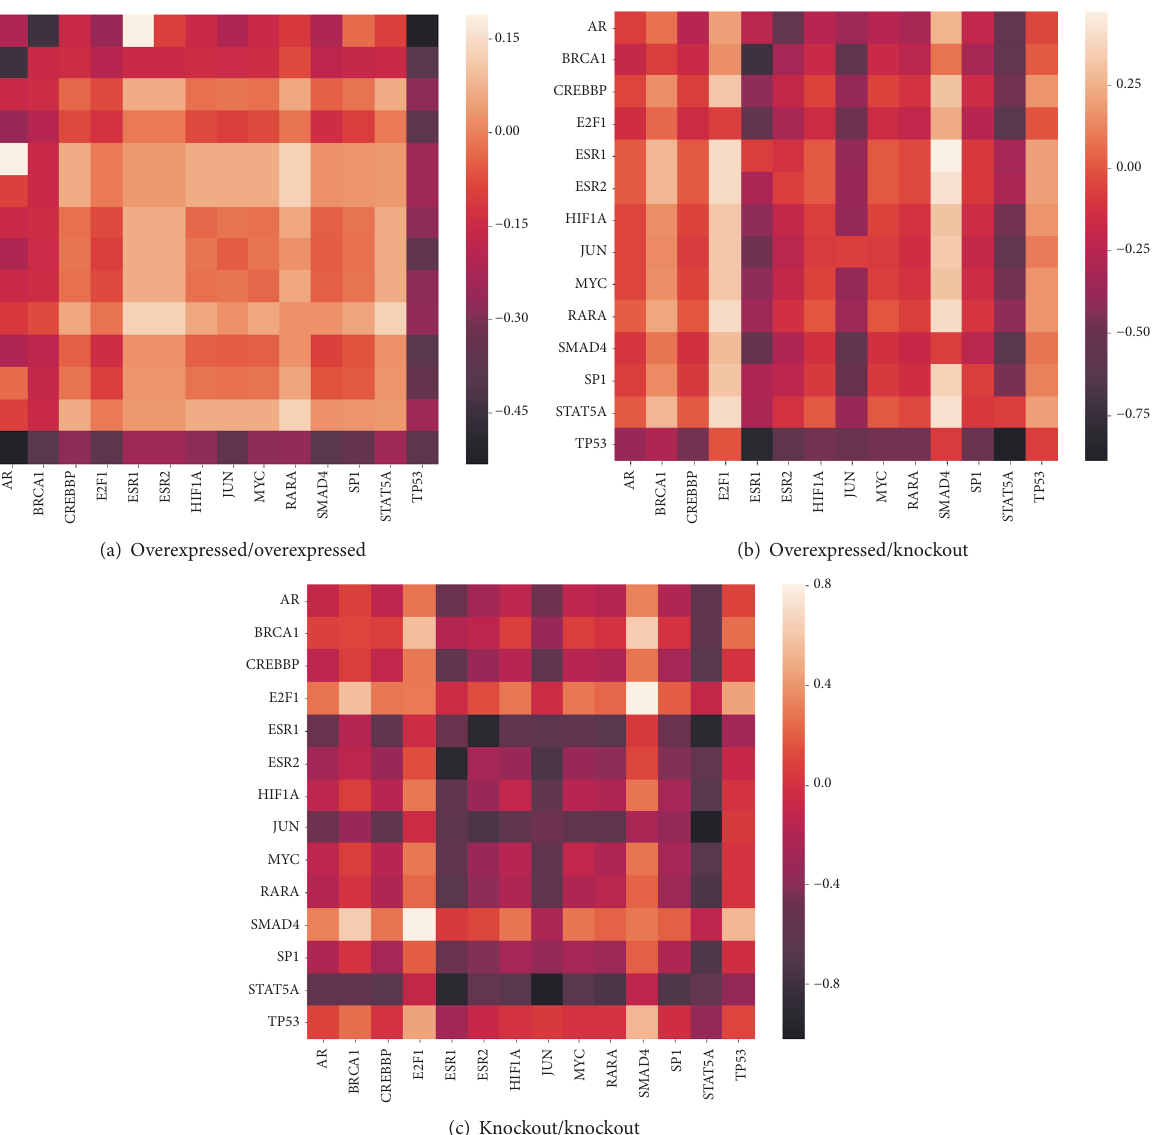
Figure 5: Proliferation indexes for two-hit perturbations. The three heatmaps show the PI value for perturbation of a couple of genes in the